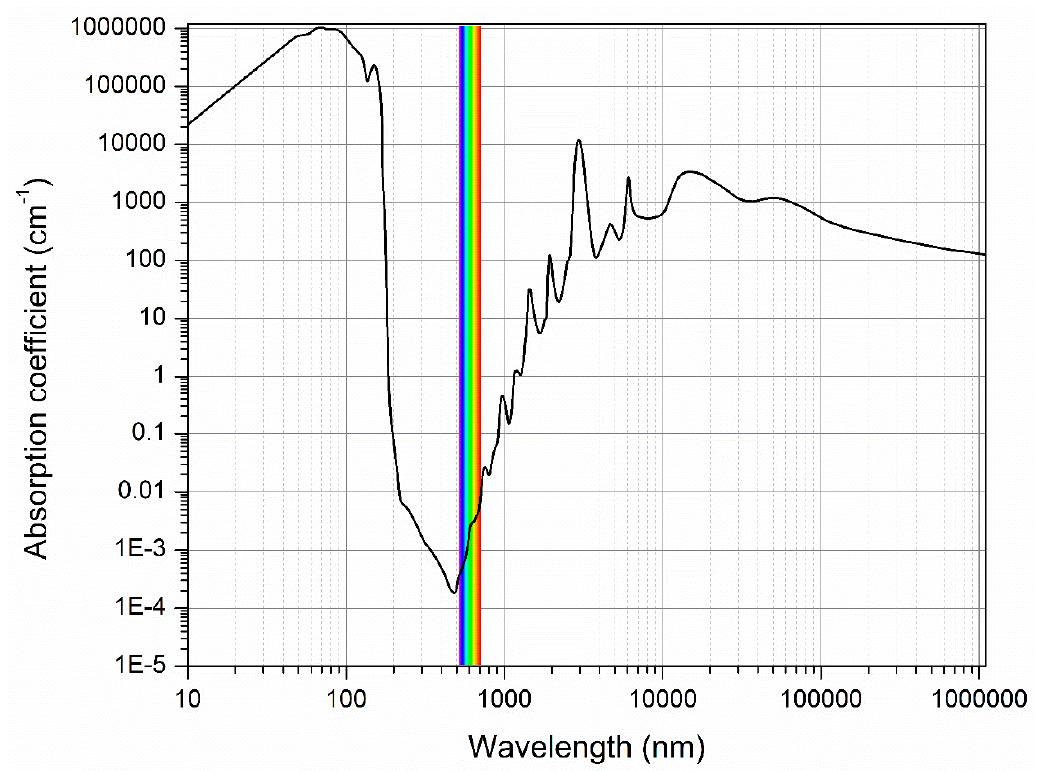
Figure 1. Water spectrum (double logarithmic plot), based on data from Segelstain [17].